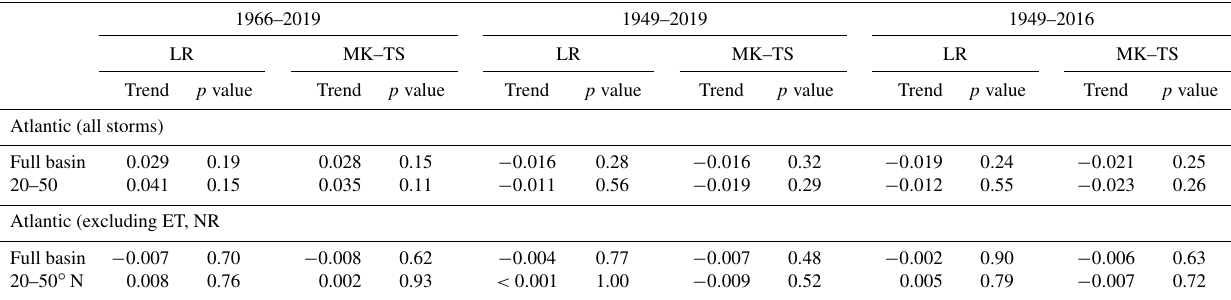
Figure 12. Cumulative distributions of curvature acceleration (kmh − 1 d − 1 ) for July–October 1966–2019 for (a) the entire Atlantic, (b) 0– 20 ◦ N, and (c) 20–50 ◦ N. Table 2. Trends in speed (kmh − 1 yr − 1 ). All storms refers to all instances of a storm recorded in the IBTrACS. ET refers to storm nature designated as extratropical, while NR refers to instances when the storm nature was not recorded. LR refers to the trend from linear regression, and MK–TS refers to the Mann–Kendall and Theil–Sen estimate of the